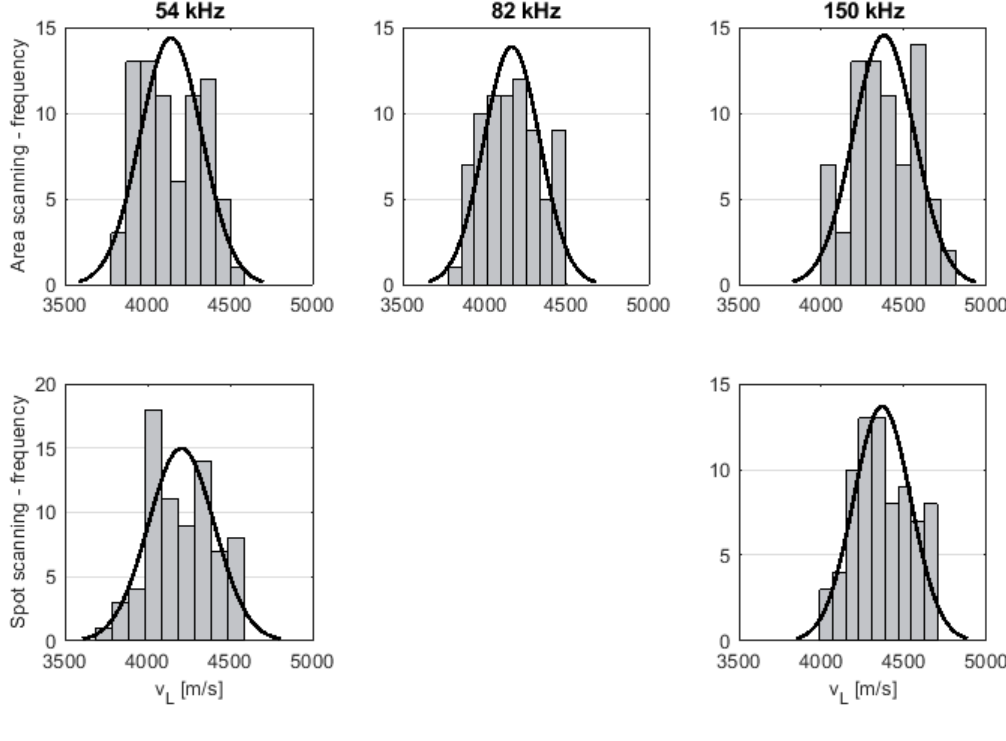
Figure 3. Test result